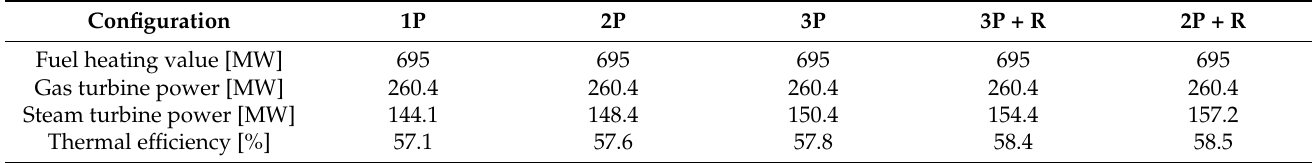
Table 2. Parameters for different combined cycle configurations (data source: [105].)